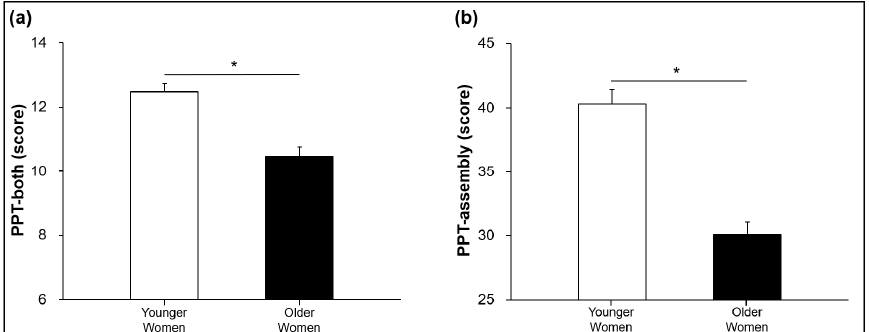
Figure 4. Purdue Pegboard Test scores in both hands and assembly tasks (M ± SE). ( a ) PPT scores in both hands task showing a significant difference between groups. ( b ) PPT scores in bimanual assembly task showing a significant difference between groups. Asterisk (*) indicates a significant difference between two groups.